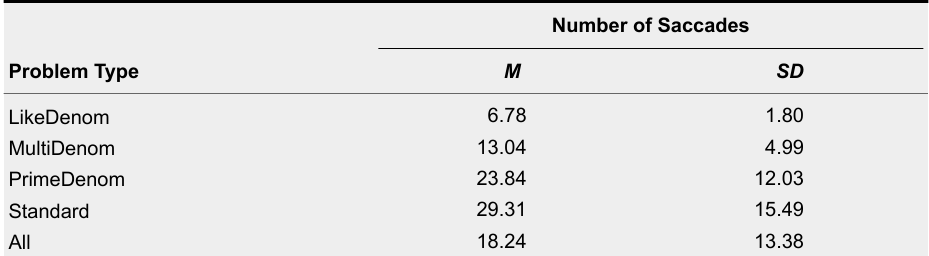
Numbers of Saccades per Problem, for Each Problem Type